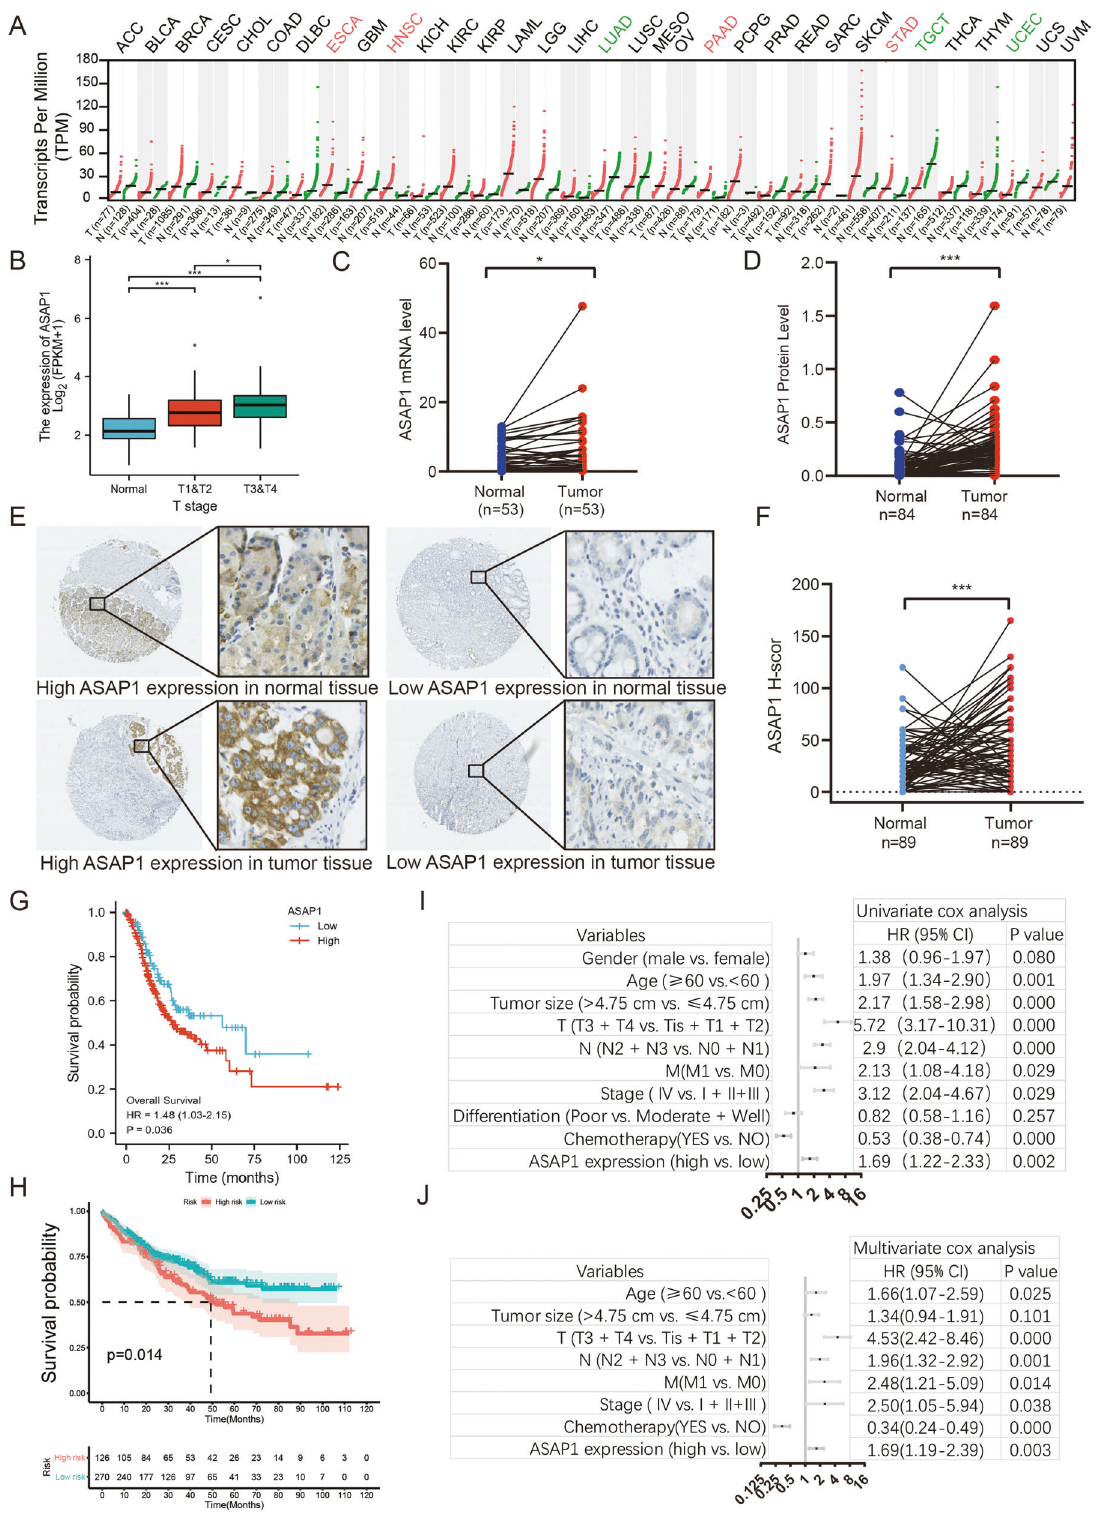
Fig. 2 Clinical signi fi cance of ASAP1 expression in GC. A The histogram shows the ASAP1 expression in 27 kinds of human normal tissues. B The expression of ASAP1 in TCGA STAD in different T stages patients. C The expression levels of ASAP1 in 53 paired gastric tumor tissues and adjacent normal tissues were detected by real-time fl uorescence quantitative PCR. D The expression levels of ASAP1 in 84 paired gastric tumor tissues and adjacent normal tissues detected by protein pro fi ling. E Representative IHC images of ASAP1 staining in the GC and normal tissue samples, Bar in 40× and 400×. F Compared ASAP1 scores in 89 paired gastric tumor tissues and adjacent normal tissues. G Kaplan – Meier OS curves of patients with GC according to ASAP1 mRNA expression in TCGA dataset. H Kaplan – Meier OS curves of 551 patients with GC according to ASAP1 scores. I , J Indicated clinicopathologic features were brought into univariable risk factor analysis ( I ) and features associated with prognosis were further brought into multivariable risk factor analysis using Cox regression model ( J ). ns not signi fi cant; * p <0.05; ** p < 0.01; *** p < 0.001. Cell Death and Disease (2023)